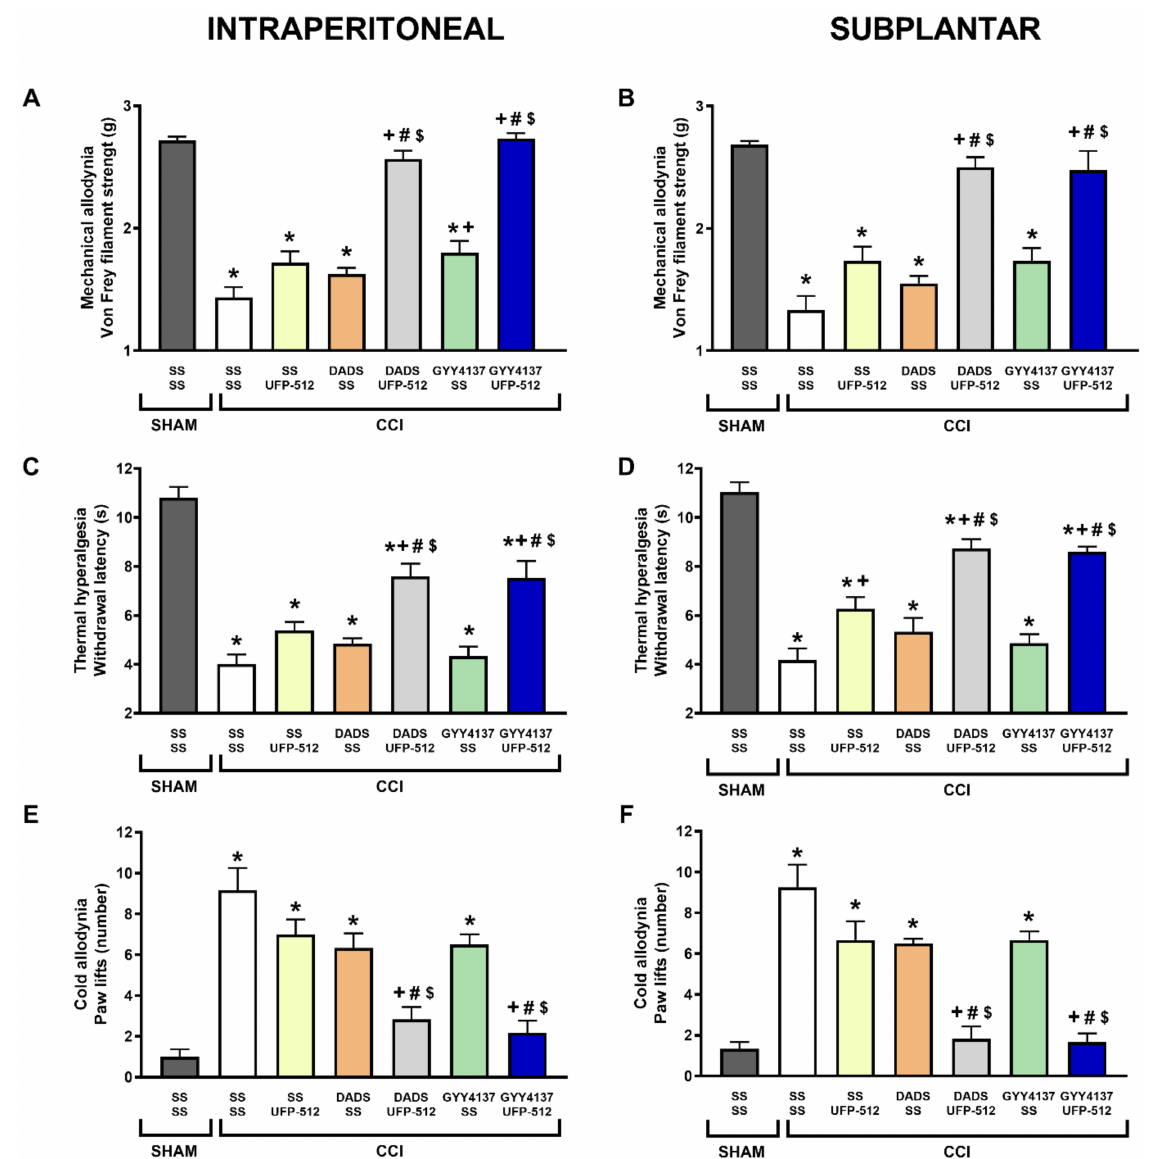
Figure 2. Effects of the co-administration of DADS or GYY4137 with UFP-512 on the mechanical allodynia, thermal hyperalgesia, and cold allodynia induced by nerve injury in mice. Effects are represented of the i.p. injection of DADS (3.5 mg/kg) or GYY4137 (0.7 mg/kg) co-administered with 1 mg/kg or 12.5 µ g of UFP-512, intraperitoneally or subplantarly injected, on the mechanical allodynia ( A , B ), thermal hyperalgesia ( C , D ), and cold allodynia ( E , F ) provoked by sciatic nerve injury (CCI) in the ipsilateral paws. The effects of these treatments administered alone are also represented. Sham-operated (SHAM) animals treated with SS plus SS are also represented. For each test, * represents significant differences vs. SHAM-animals treated with SS plus SS, + vs. CCI-mice treated with SS plus SS, # vs. CCI-mice treated with SS plus UFP-512 and $ vs. CCI-mice treated with DADS or GYY4137 plus SS ( p < 0.05; one-way ANOVA, followed by Tukey test). Each column represents the mean, and vertical bars indicate SEM ( n = 6 animals for